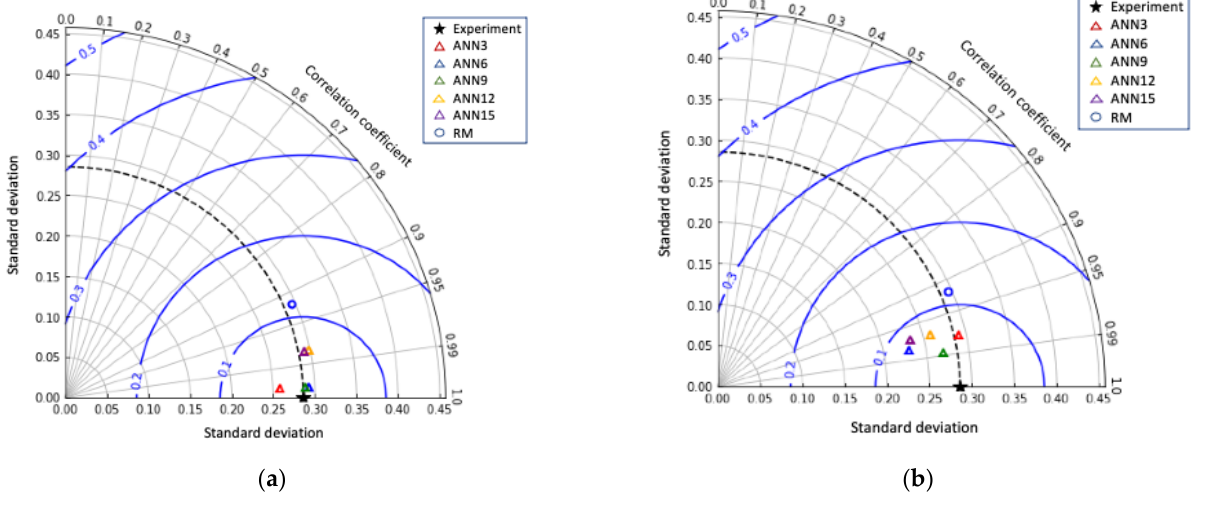
Figure 7. Taylor’s diagram showing the relationship between standard deviation, correlation coeffi- cient, and root mean square error (represented with blue lines) for C BD ; ( a ) Training and ( b ) Valida- tion. Table 4. Performance evaluation of the assessed ANN models.